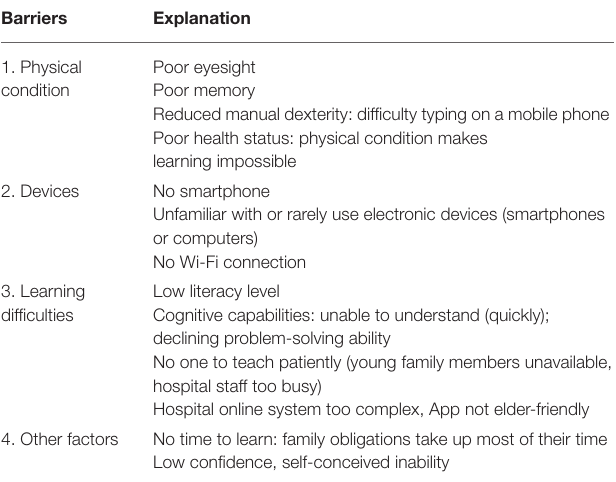
TABLE 2 | Perceived barriers to learning and using mobile health technology.